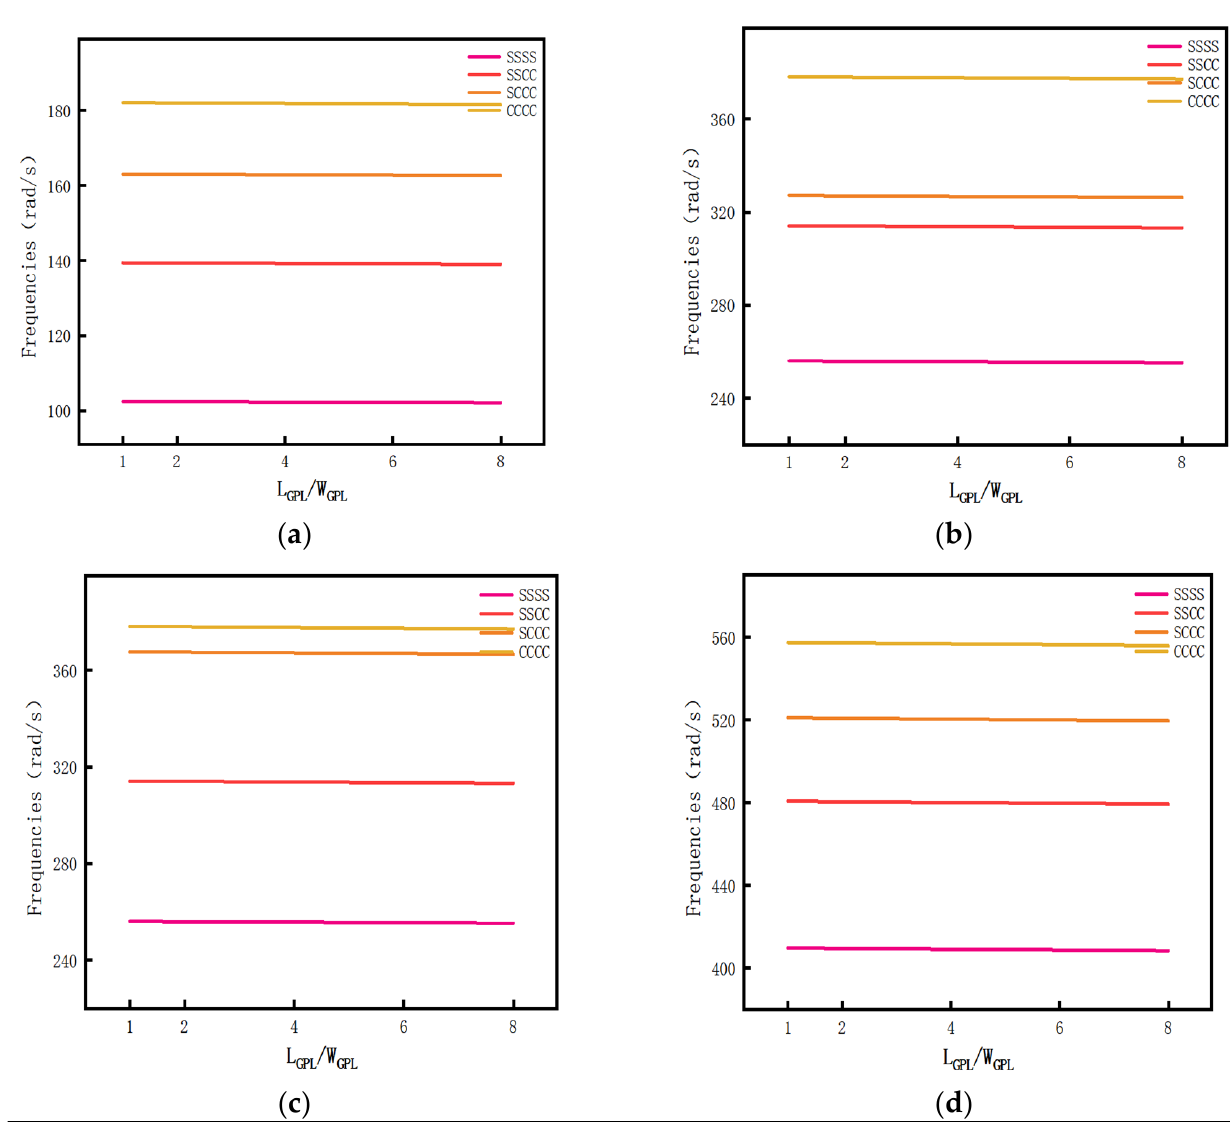
Figure 9. The relationship curve between L GPL / W GPL fraction and vibration frequency. ( a ) First order vibration mode, ( b ) second order vibration mode, ( c ) third order vibration mode, and ( d ) fourth order vibration mode.